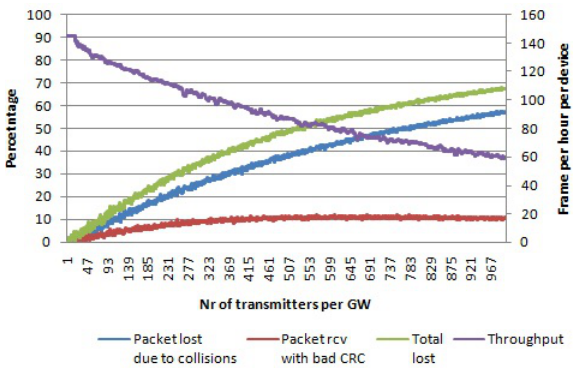
Figure 7. Percentage of packets lost due to collisions and percentage of packets received with the wrong payload CRC per number of transmitters per gateway. Average throughput per device. Payload size 20 bytes, single channel, multiple SFs.